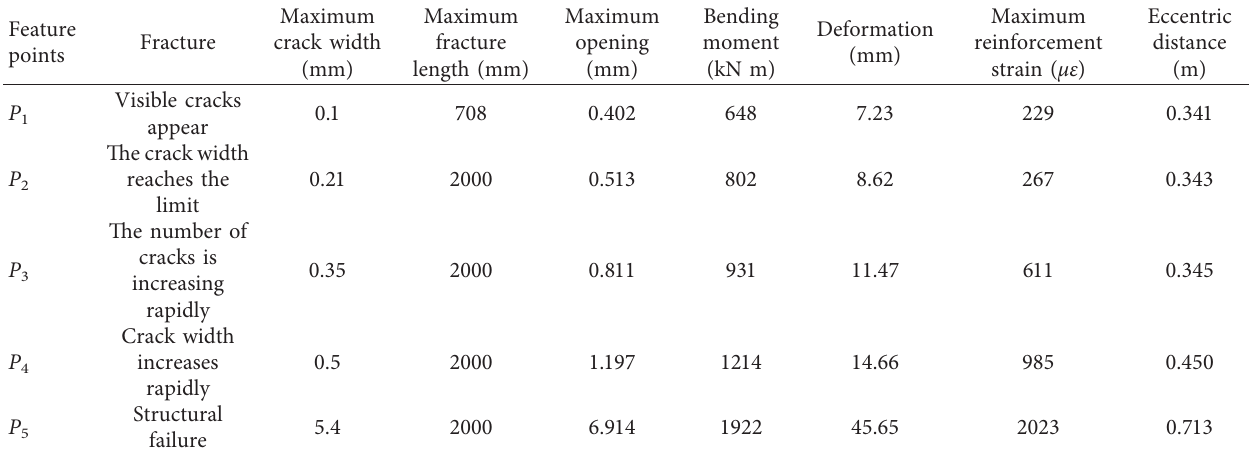
Table 1: The relationship between crack development and structural mechanical